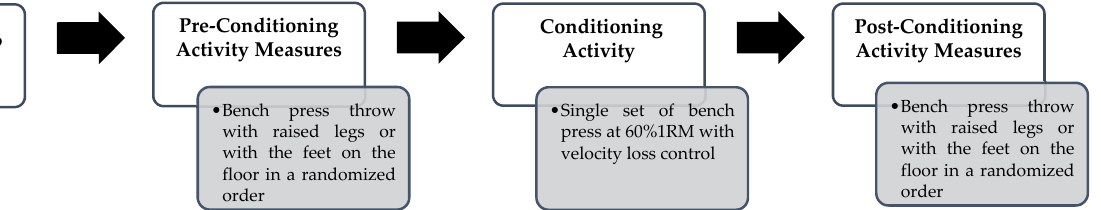
Figure 1. Schematic representation of the experimental session.